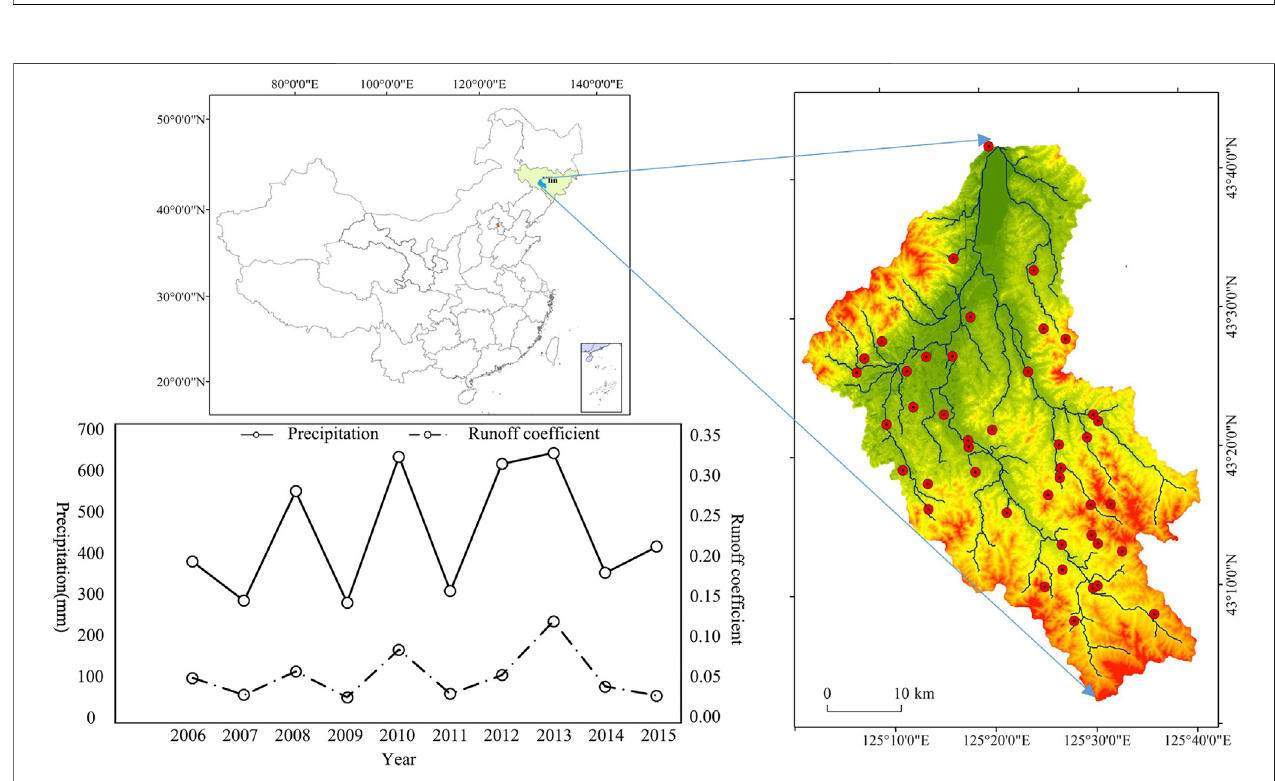
FIGURE 4 | Location of the Xinlicheng Reservoir Basin